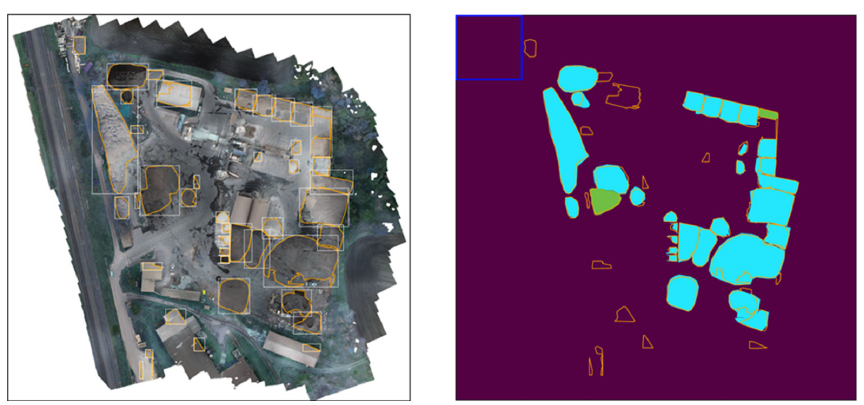
Figure 17. Results on Test Site B. Colors and shapes have the same meaning as on test site A.